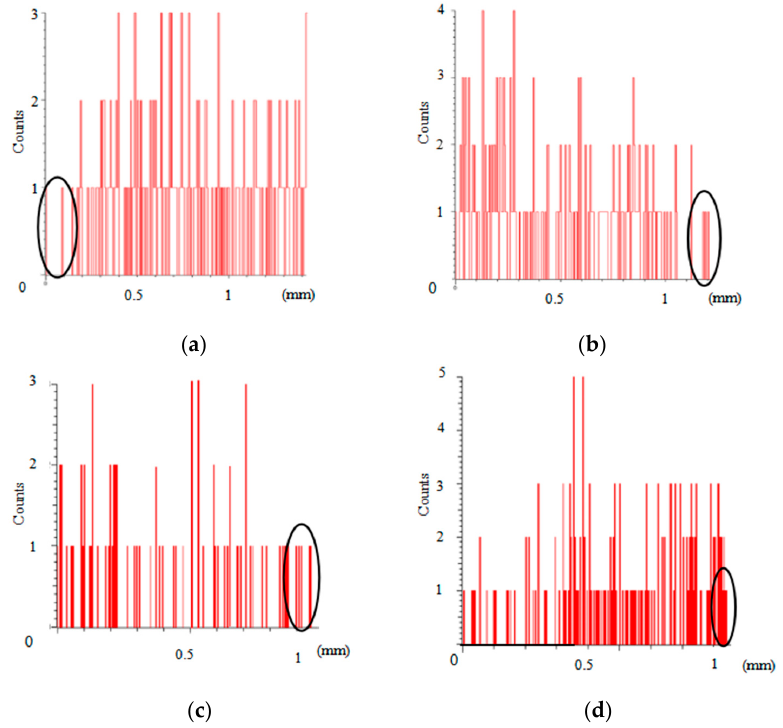
Figure 10. Energy spectrum analysis of the content of Ni element in the welded joints: ( a ) Sample 1; ( b ) Sample 2; ( c ) Sample 3; ( d ) Sample 4.